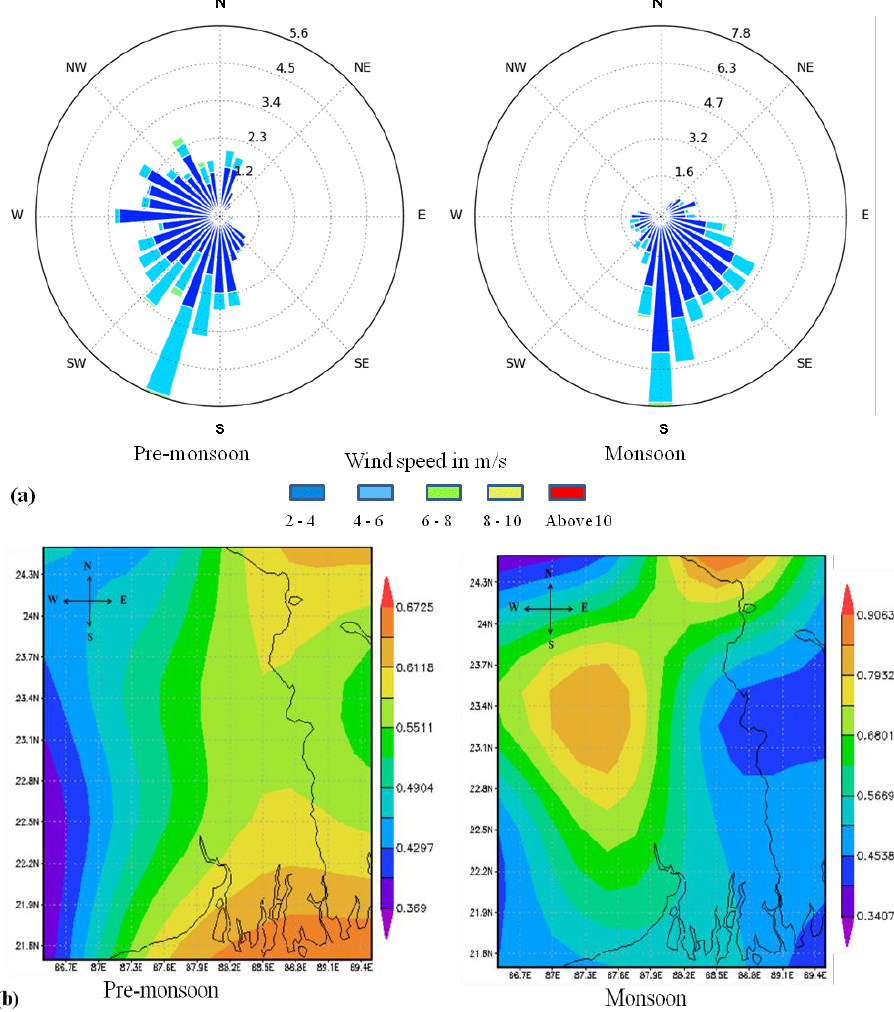
Figure 2. Wind pattern and AOD over Gangetic West Bengal during pre-monsoon and post monsoon seasons. ( a ) Wind rose diagrams showing dissimilarity in the distribution of wind speed and direction for a station (Dumdum, Kolkata: latitude: 22.62°N; longitude: 88.42°E); ( b ) AOD contours during two seasons.